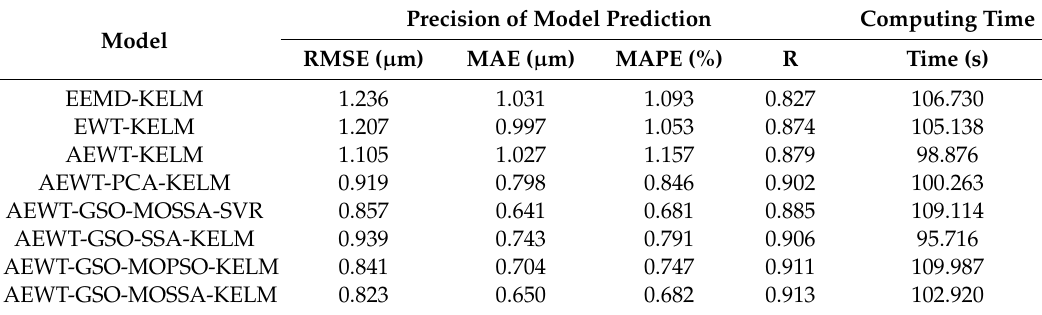
Figure 9. The box plots of error distribution with different models. Table 5. The performance of di ff erent